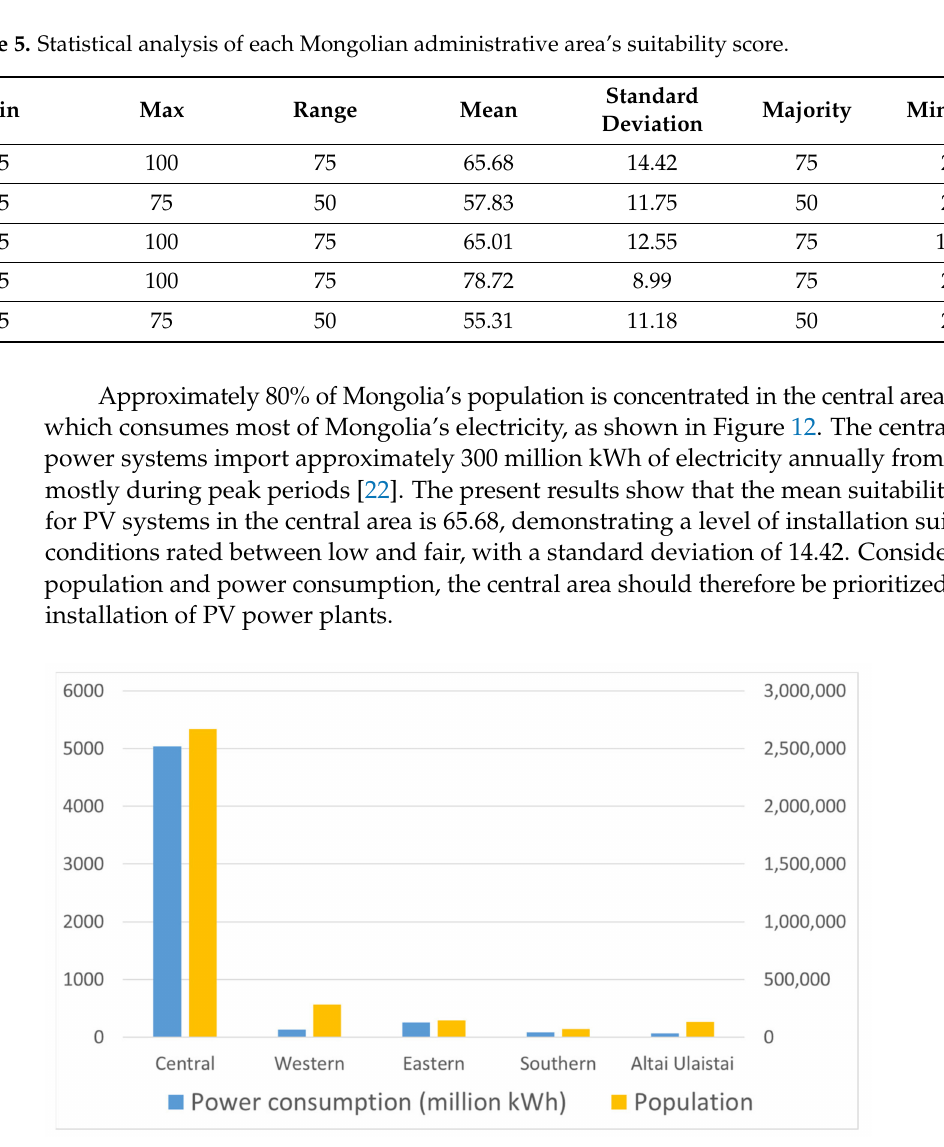
Figure 12. Power consumption and population for each Mongolian regional administrative